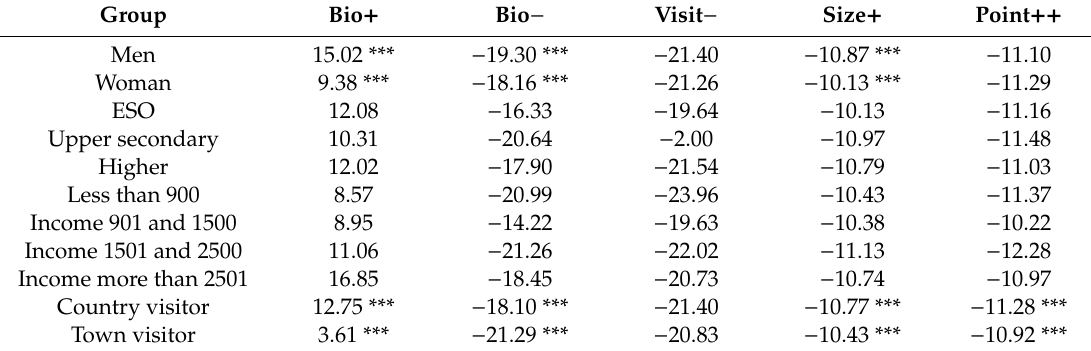
Table 6. Average willingness to pay across socioeconomics